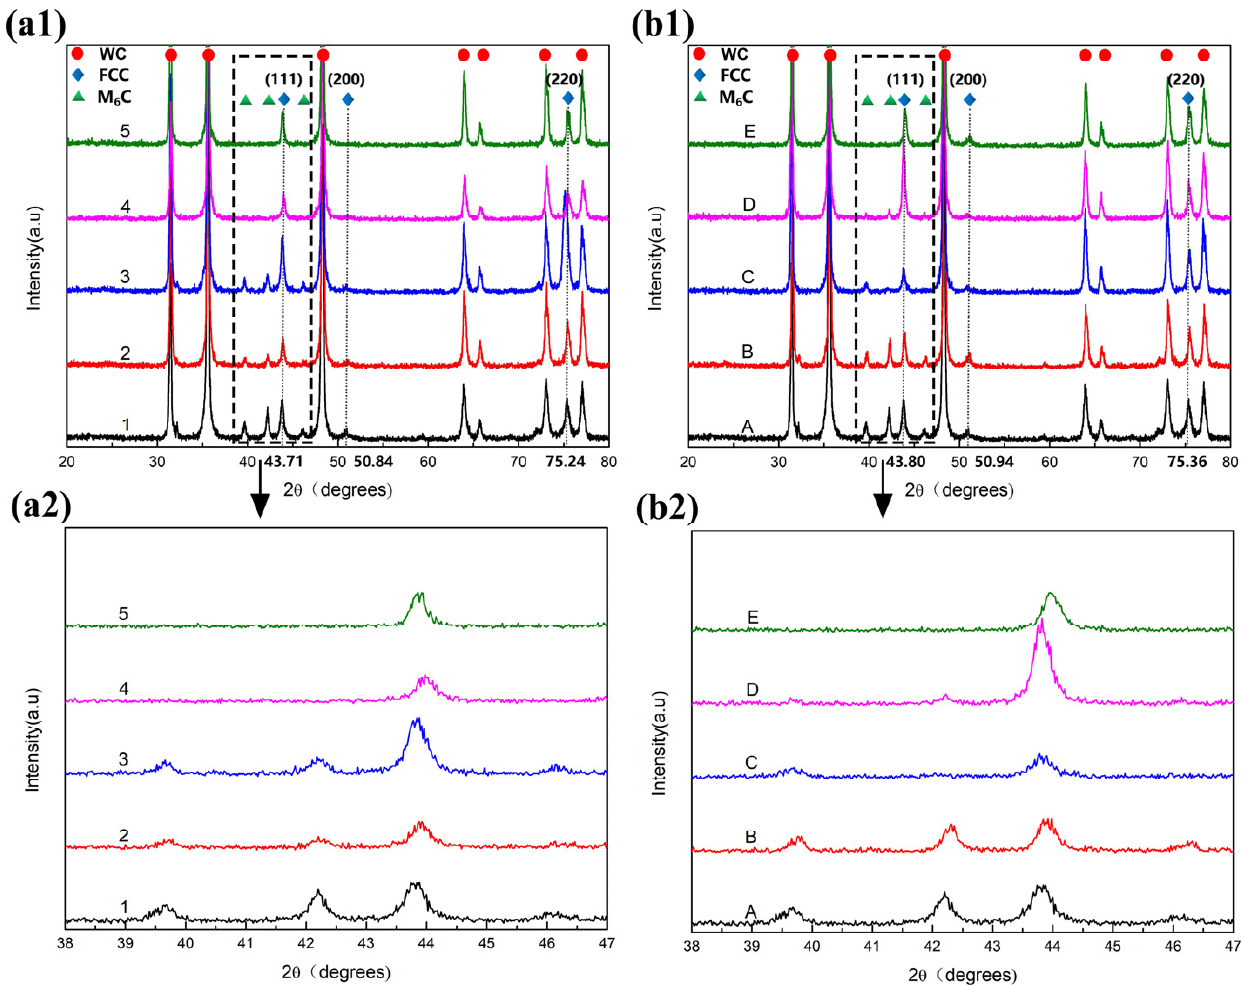
Figure 1. XRD patterns of Alloy 1–Alloy 5 ( a1 , a2 ) and Alloy A–Alloy E ( b1 , b2 ).